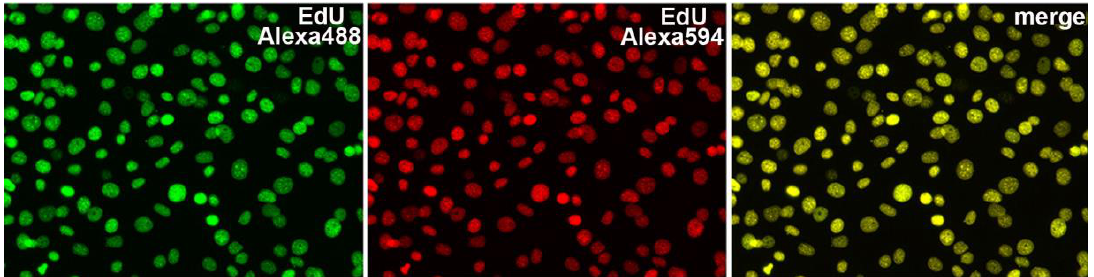
Figure 5. Labeling of DNA using EdU. NIH 3T3 cells labeled by incubation overnight with 2 μM of EdU were fixed and reacted successively with 10 μM of Alexa488-azide and 10 μM of Alexa594-azide, respectively. The cells were imaged by fluorescence microscopy. ( Left ) Alexa488-azide stain. ( Center ) Alexa594-azide stain. ( Right ) Overlay of the Alexa488 and Alexa594 images. Adapted with permission from Salic, A., Mitchison, T.J., 2008, A chemical method for fast and sensitive detection of DNA synthesis in vivo. Proc Natl Acad Sci U S A 105, 2415–2420, Copyright (2008) National Academy of Sciences U.S.A [76].